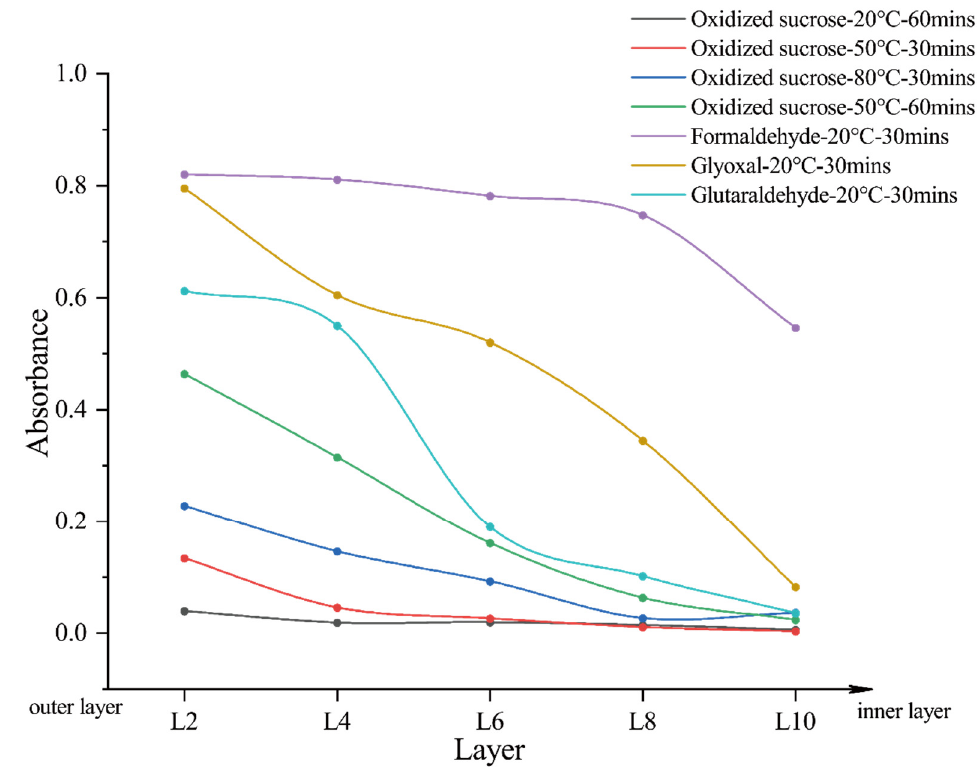
Figure 12. Absorbance of Schiff’s reagent solution stained with cellulose films from outer layer to inner layer (2nd, 4th, 6th, 8th, and 10th layers).